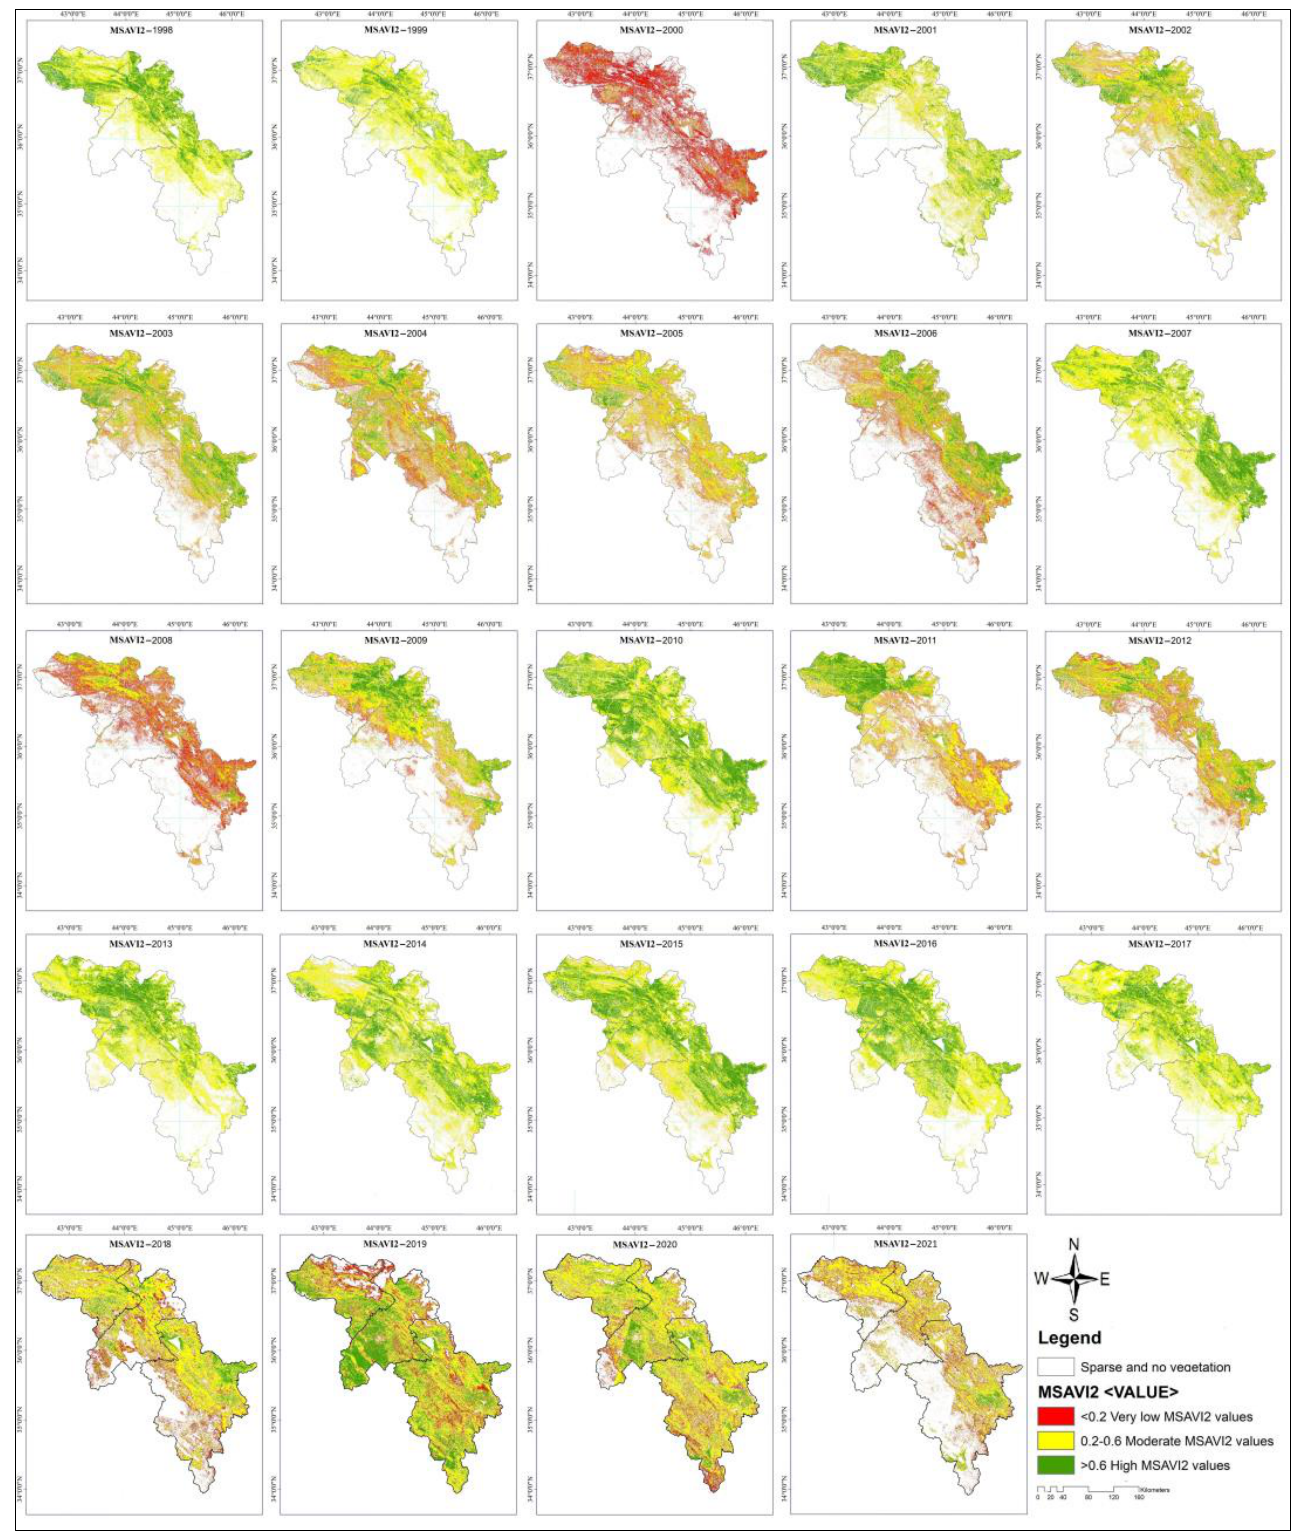
Figure 5. Spatial variation of the MSAVI2 − based vegetation density classes from 1998 to 2021.